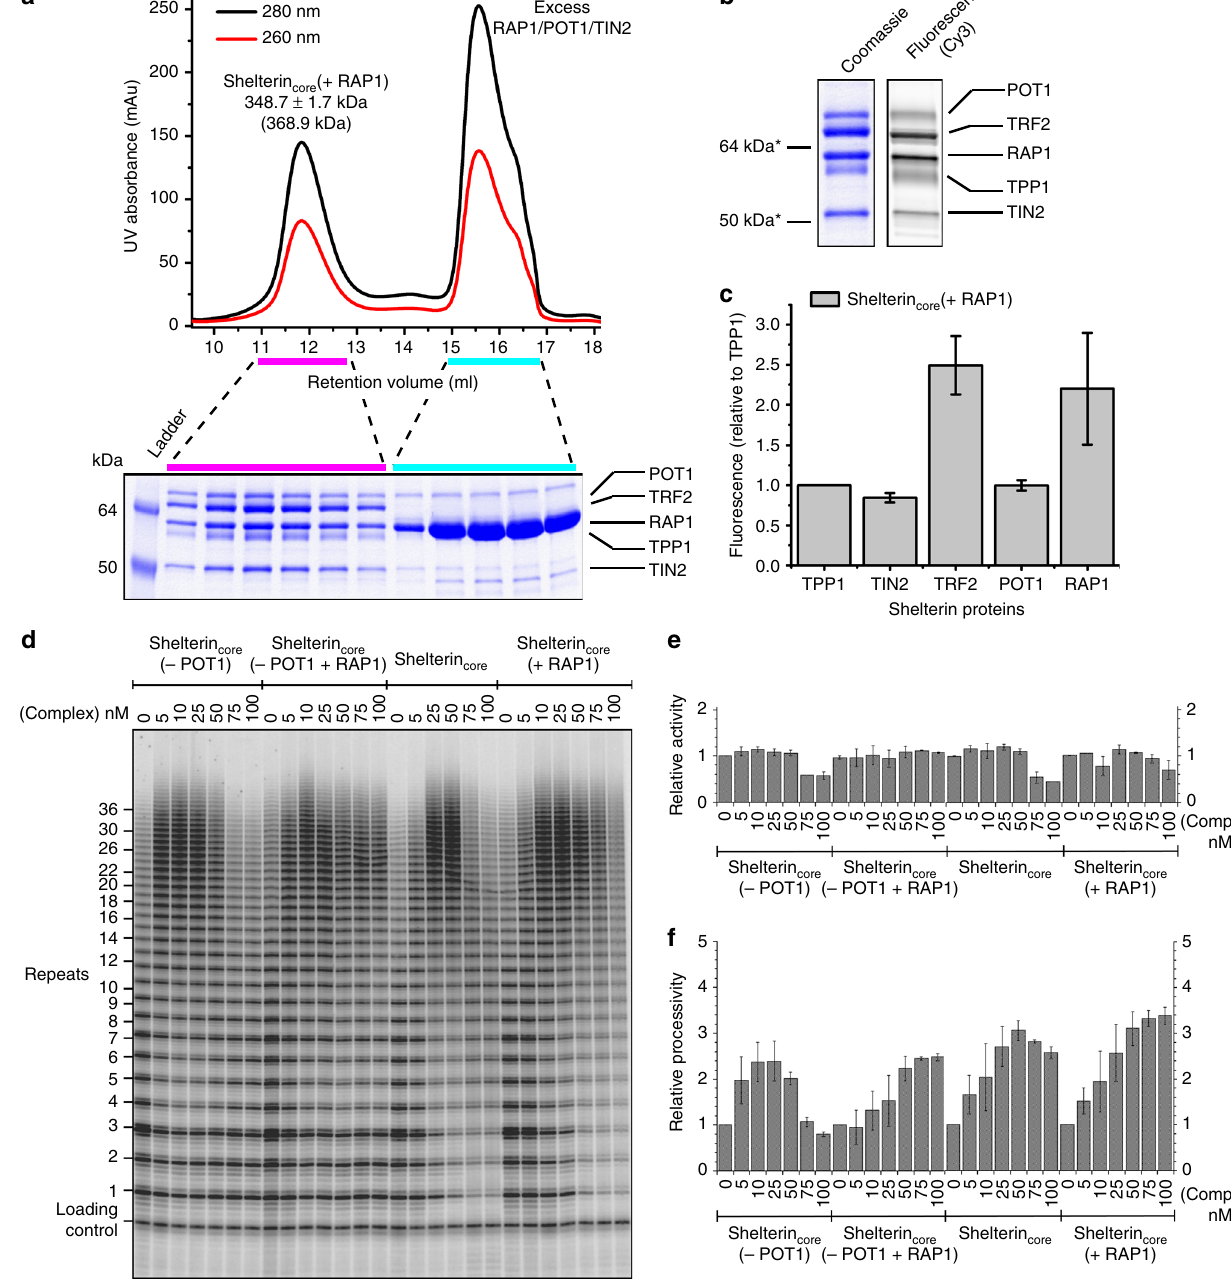
Fig. 7 Incorporation of RAP1 into shelterin core complex does not change TRF2:TIN2 complex stoichiometry, and there are two each of RAP1 and TRF2. Telomerase stimulation by shelterin complexes is also not affected by RAP1 inclusion. a Superose 6 gel- fi ltration trace of co-expressed shelterin core (+RAP1) complex (RAP1 – TRF2 – TIN2 – TPP1 – POT1) showed a mono-disperse peak (left peak) with SDS-PAGE showing fi ve distinct Coomassie-stained bands representing the fi ve shelterin proteins. SEC-MALS analysis determined the protein complex to be 348.7 ± 1.7 kDa, with the bottom number in parentheses being the theoretical mass for a 2:2:1:1:1 (RAP1:TRF2:TIN2:TPP1:POT1) complex. The right peak is composed of excess un-incorporated RAP1, POT1 and TIN2. b Puri fi ed singly ybbR-tagged shelterin core (+RAP1) complex labeled with Cy3-CoA dye and compared with Coomassie-stained bands as reference. *Molecular weight is an apparent value of SeeBlue Plus2 protein marker (Thermo Fisher) on a tris-glycine gel. c Quanti fi cation of fl uorescence- intensity showed TRF2:TIN2 relative stoichiometry to be 2:1 ( P < 0.05) while TRF2:RAP1 is 1:1. Error bars indicate s.d. for three independent experiments performed with three different protein preparations. d Direct telomerase assay to determine the effects of RAP1 inclusion on processivity stimulation by shelterin core ( − POT1) or shelterin core complexes. e Total activity of telomerase primer elongation products (relative to no-protein lane) with bound shelterin protein complexes at various concentrations (nM). f Telomerase processivity (relative to no-protein lane) with each shelterin protein/complex. (For panels e and f , error bars indicate the range for two independent